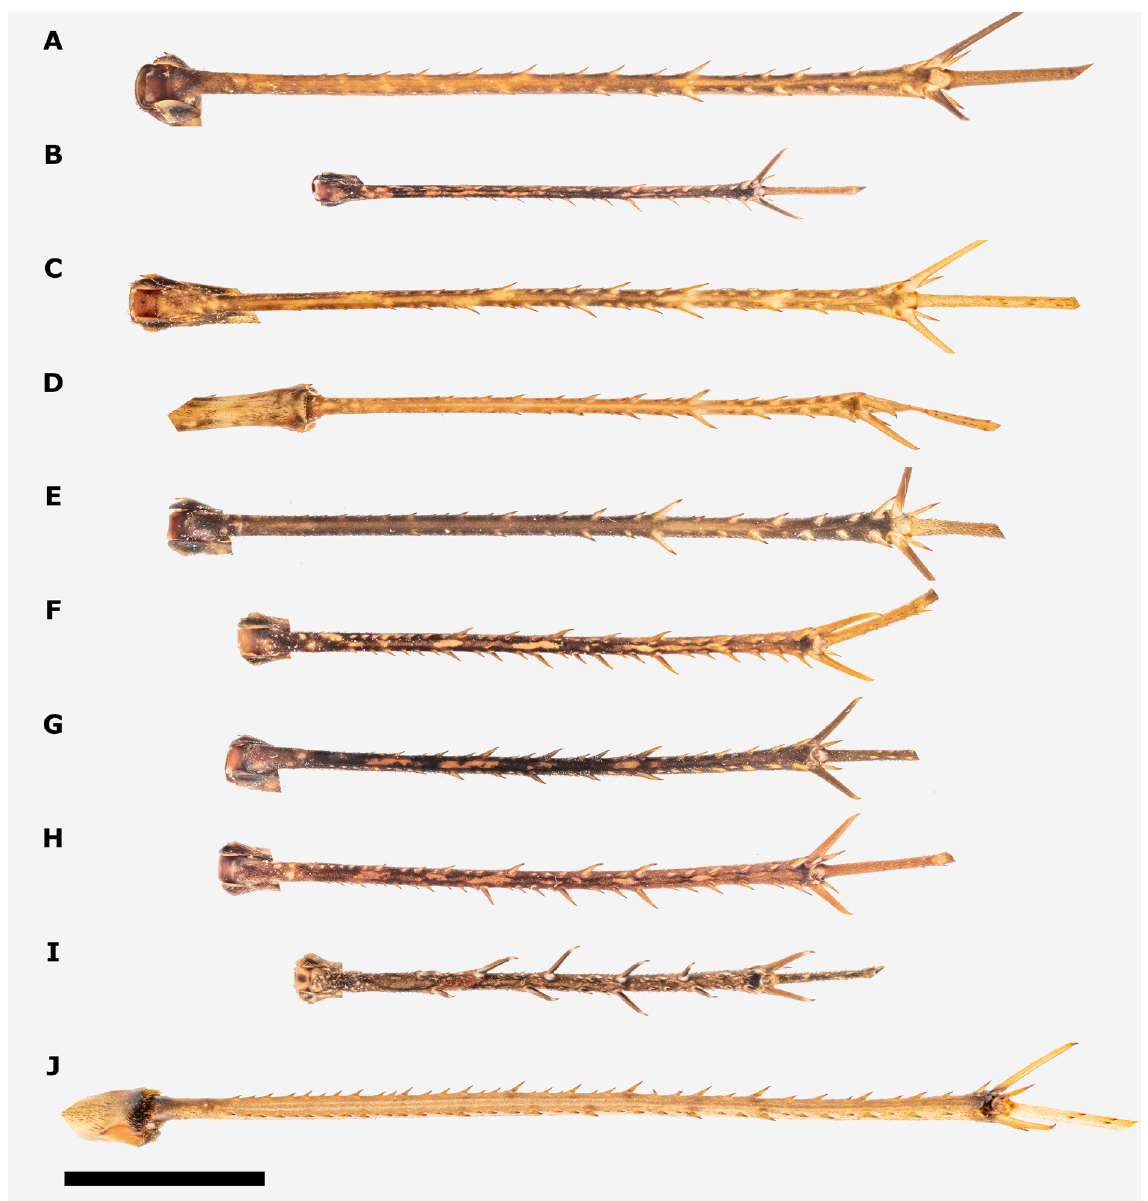
Fig. 7. Left hind tibia of cave wētā in the genus Pleioplectron Hutton, 1896, dorsal view. A . P. simplex Hutton, 1896, adult ♀, Hinewai Reserve, Akaroa (MPN CW4114). B . P. hudsoni Hutton, 1896, adult ♂, Otaki Forks, Tararua Forest (MPN CW3890). C . P. thomsoni (Chopard, 1923) comb. nov., adult ♂, Claremont Bush Reserve, South Canterbury (MPN CW4115). D . P. triquetrum sp. nov., adult ♂, Hinau Track, Kaikōura (MPN CW3921). E . P. auratum sp. nov., adult ♂, Whites Beach, Rarangi (MPN CW4295). F . P. gubernator sp. nov., adult ♂, Lewis Pass (MPN CW4066). G . P. caudatum sp. nov., adult ♂, Moeraki River (MPN CW4239). H . P. flavicorne sp. nov., adult ♀, Brewster Hut Track, Haast Pass (MPN CW3896). I . P. crystallae sp. nov., adult ♂, Cave Brook, Gouland Downs (MPN CW3994). J . P. rodmorrisi sp. nov., adult ♂, Hodder River, Inland Kaikōura Range (MPN CW3819). Scale bar = 5